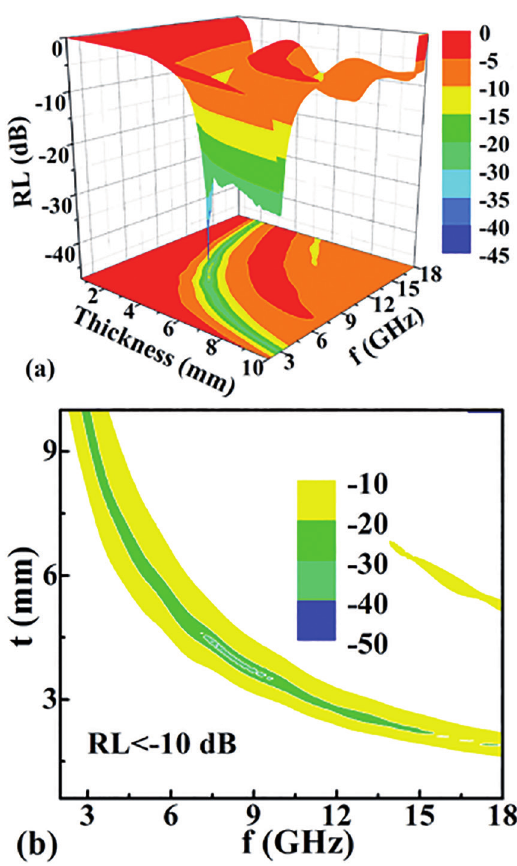
Figure 4: (a) 3D representation of RL as a function of frequency and (b) contour map of the bandwidth with RL<-10 dB (70% absorption) as a function of the absorber thickness.